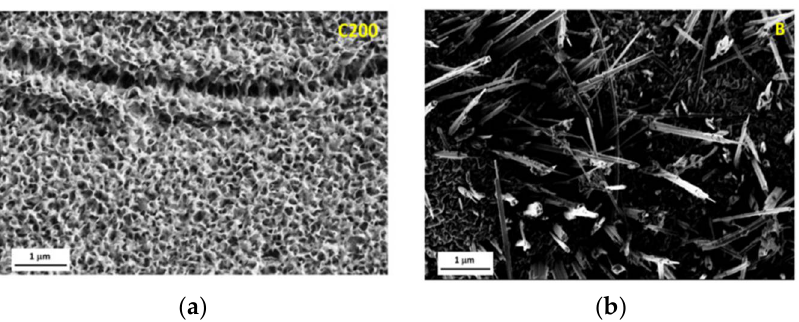
Figure 12. Schematic illustration of the formation of the superhydrophobic film on the copper in- terface. ( a ) The condensation reaction between the oxidized copper surface and silanol. ( b ) The horizontal condensation reaction among silanols. ( c ) The form of grafted polysiloxane. Reprinted with permission from Ref [66]. Copyright 2012 Elsevier.